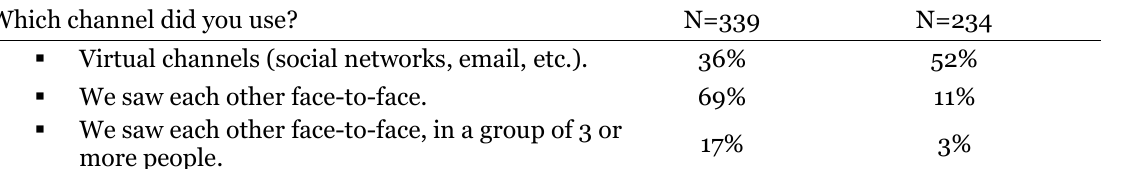
People they knew People they met ahead of the course during the